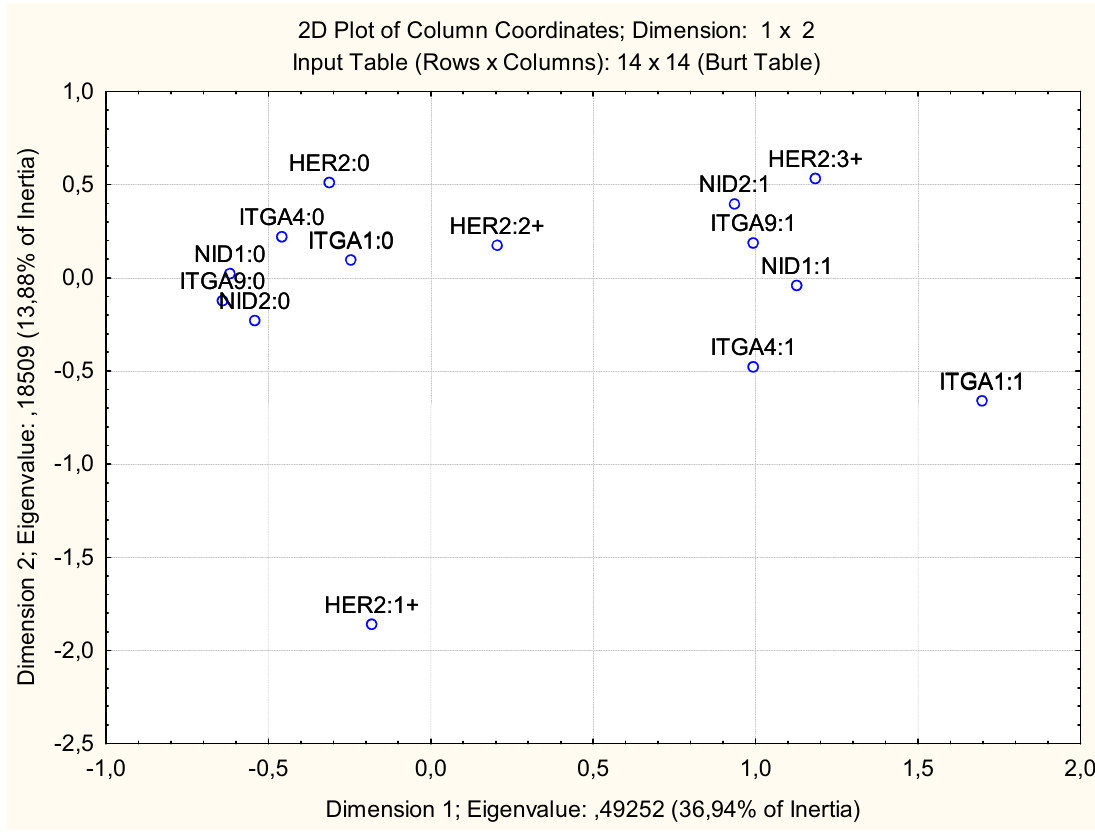
Figure 3. High HER2 expression (IHC score 3+) is associated with the methylated status of the ITGA1, ITGA4, ITGA9, NID1 , and NID2 genes in breast cancer samples by the results of multiple correspondence analysis. The nonmethylated gene status is designated as “0” at the gene symbol; methylated as “1” at the gene symbol. Multiple correspondence analysis allows investigating the structure of objects and variables that characterize them, initially included in the multi-input table, where objects (samples) are located in rows, and grouping variables (N) in columns, which are object coordinates in the N-dimensional space. The goal of the multiple correspondence analysis is to represent the contents of the table transformed into a table of relative frequencies of grouping variables as a projection on a 2-dimensional space. Dimension 1 explains 36.94% inertia, that is, for the data in question, the values of the relative frequencies that are reconstructed from one dimension contribute to the χ 2 statistics (and, therefore, inertia) for 36.94% of the original. Both dimensions explain 50.82% of the χ 2 value. Groups of samples that have signs of grouping variables located in the same fields are considered the closest. For example, on this plot, patients with a methylated status of the ITGA9 and NID2 genes and a high level of HER2 expression in breast cancer samples form a pronounced common cluster. A somewhat less pronounced commonality is demonstrated by the samples with methylated status of the ITGA1 , ITGA4 , and NID1